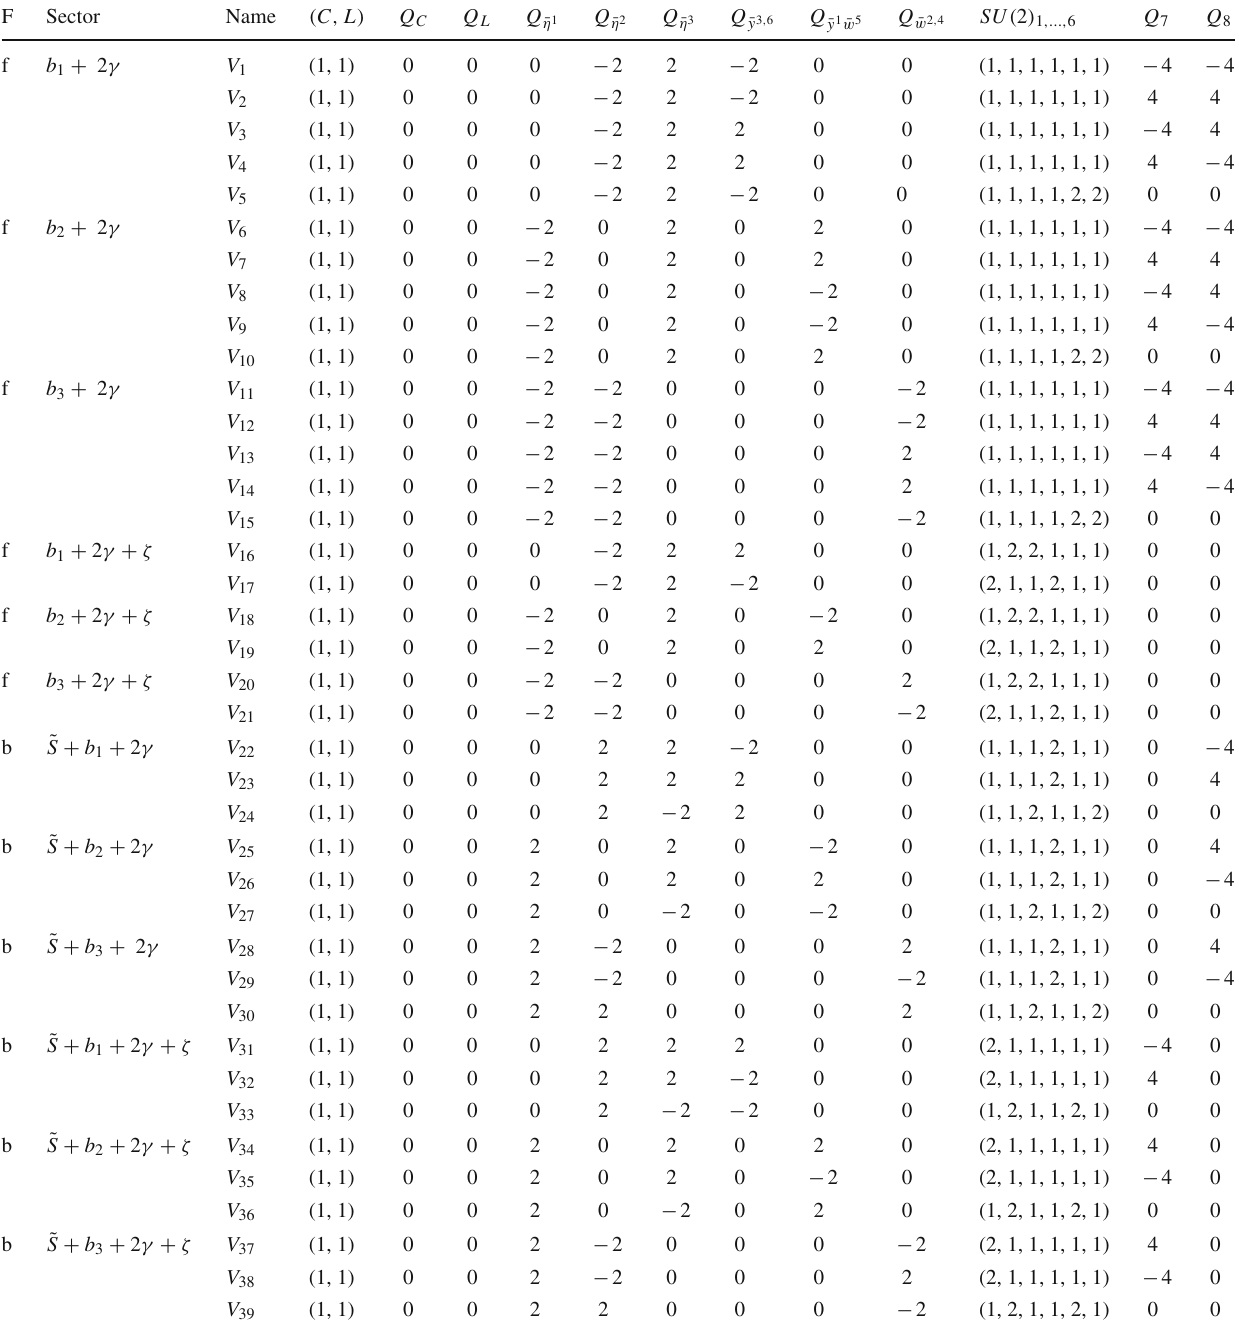
Table 6 SO ( 10 ) singlets with ˜ S -partners. All charges are multipled by 4 and the combination ζ = 1 + b 1 + b 2 + b 3 has been